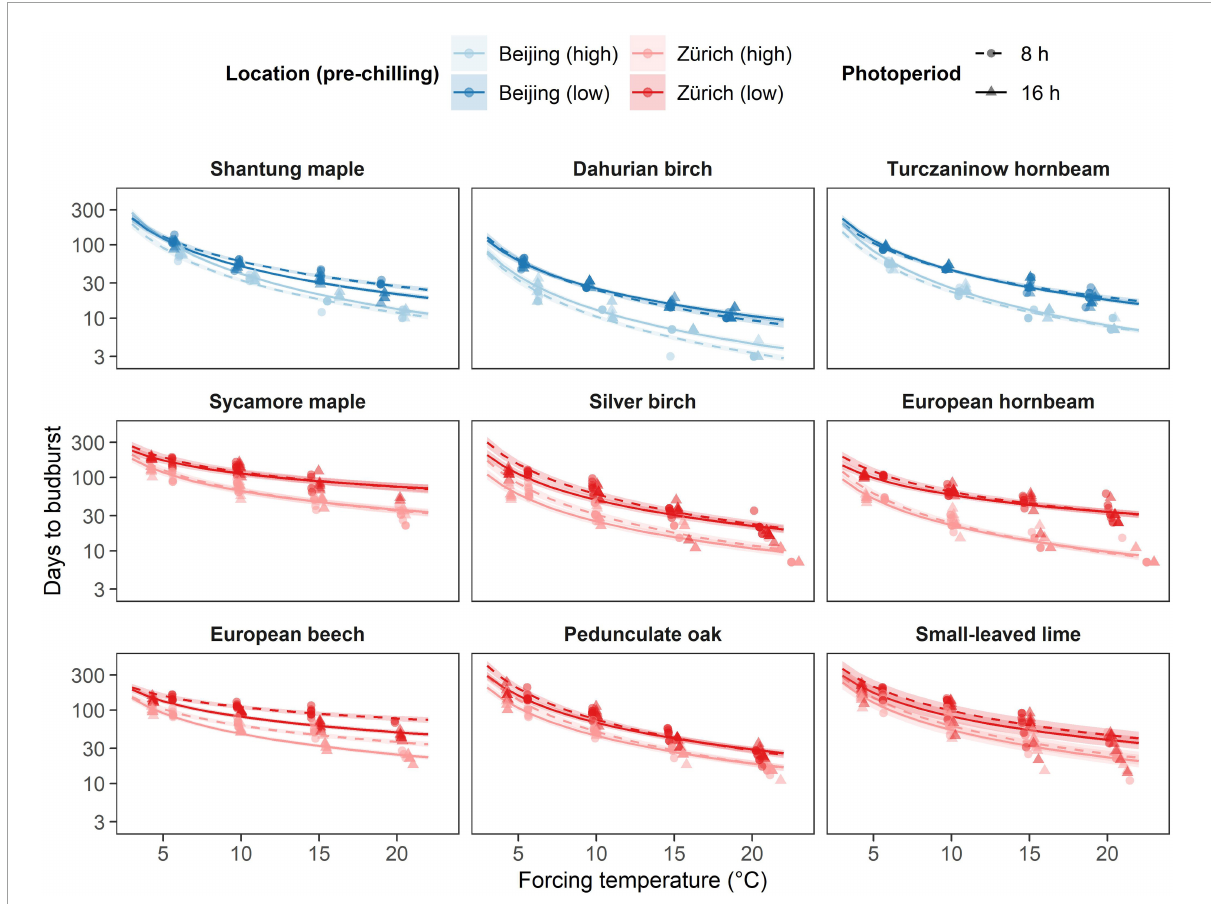
FIGURE2 Effect of the different temperature treatments (forcing) on time to budburst (days) under different pre-chilling conditions and photoperiod. The predicted relationships from the final model are represented as solid lines with corresponding 0.89 credible intervals. Chilling treatments and locations are represented by colors, where blue indicated species growing near Beijing and red indicates species growing near Zurich. Pre-chilling conditions are indicated with lower brightness (high pre-chilling) and higher brightness (lower pre-chilling), whereas photoperiodic treatments are represented by solid lines and triangles (16 h photoperiod) and dashed lines and points (8 h